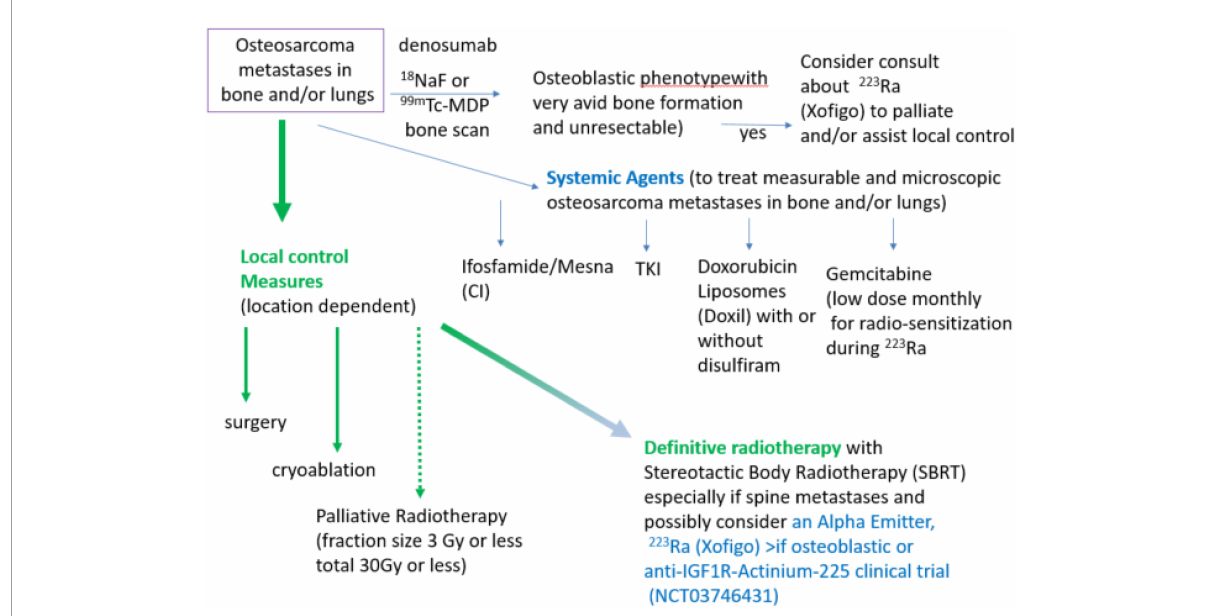
FIGURE1 Algorithm of treatment of metastatic, recurrent osteosarcoma with systemic agents, local control measures, and with alpha-emitters 223 Ra or Anti-IGF1R-Actinium-225. Note if unresectable, referral to a center with expertise in administration of alpha emitters in combination with radiotherapy will be